Question: In one sentence, what is this figure communicating?
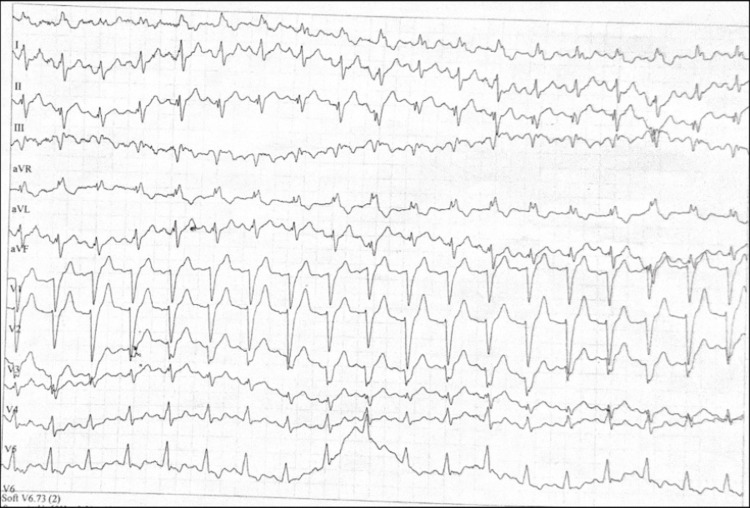
Answer: Electrocardiogram at peak exercise demonstrating new-onset left bundle branch block.